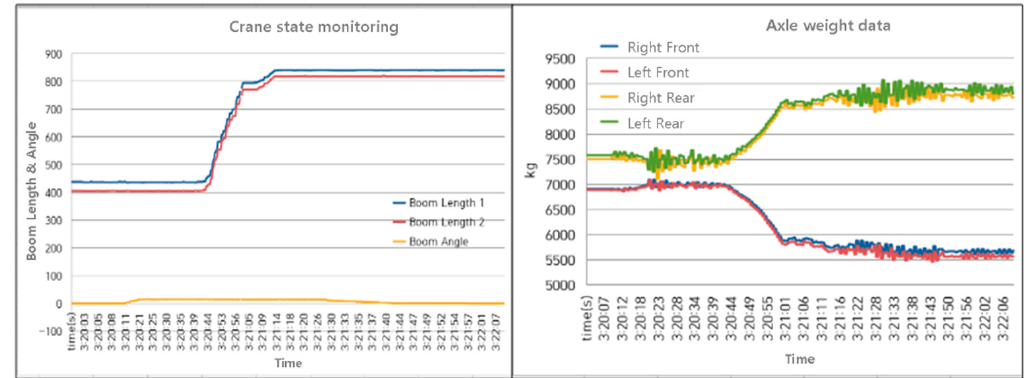
Figure 10. The result of the axel loads according to changes boom length. Figure 10. T he result of the axel loads according to changes boom length.